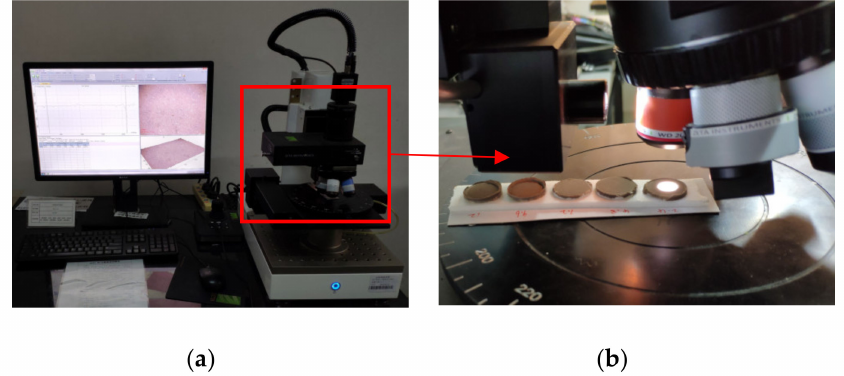
Figure 7. White light interferometry using Zeta 3D surface topography instrument. ( a ) White light interferometer; ( b ) Sample